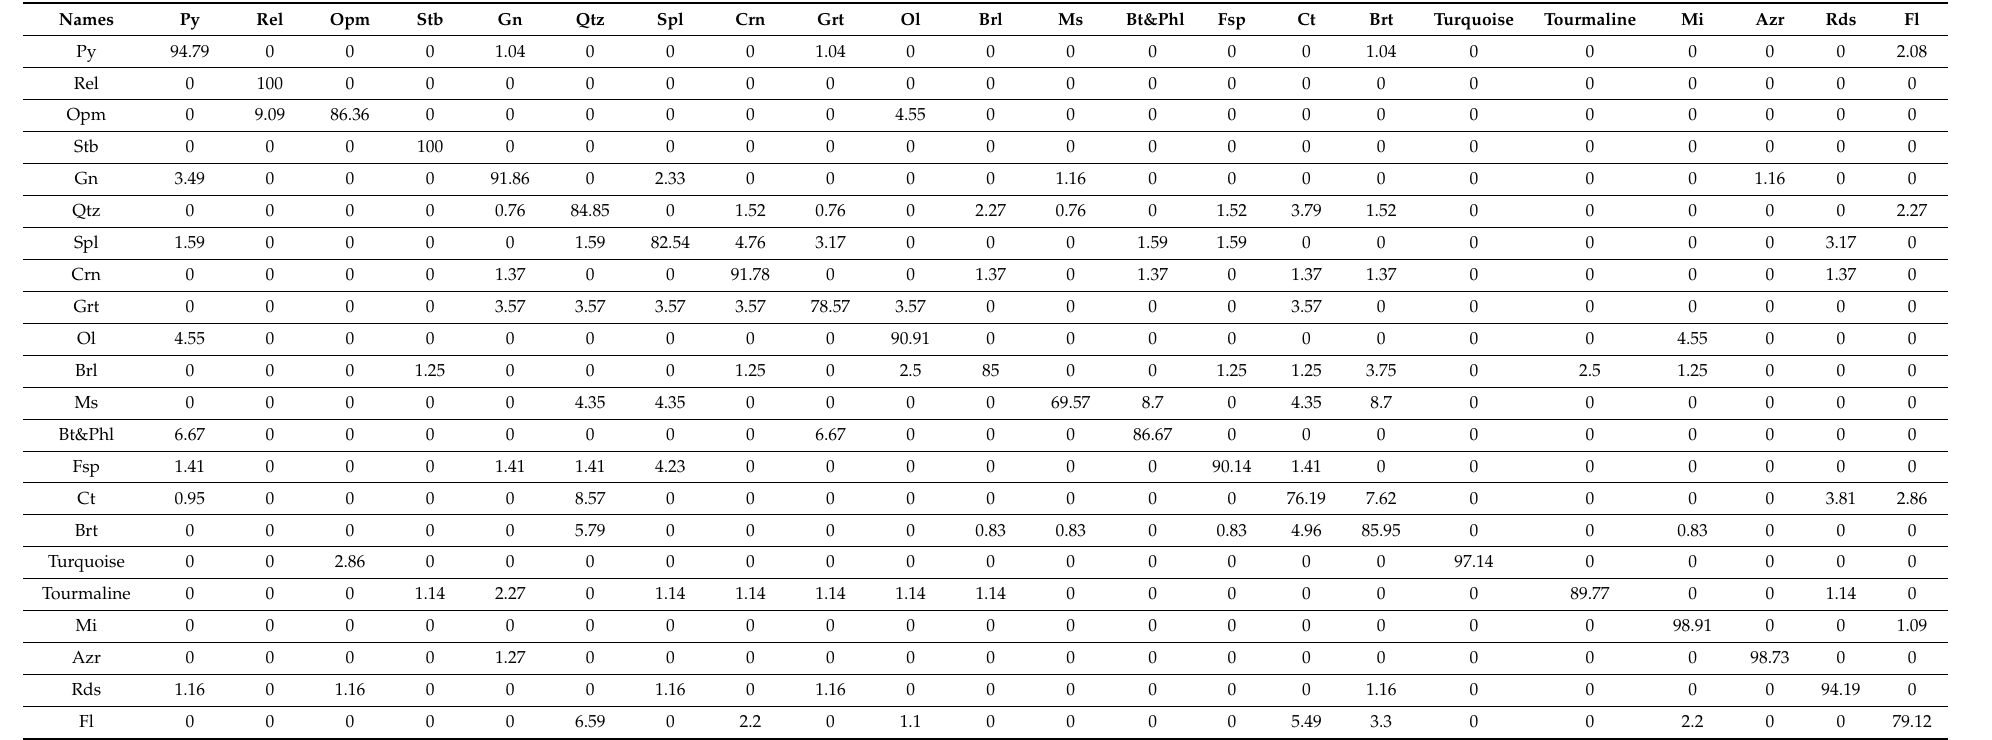
Table 10. The confusion matrix of 22 minerals in validation set of the dataset-1